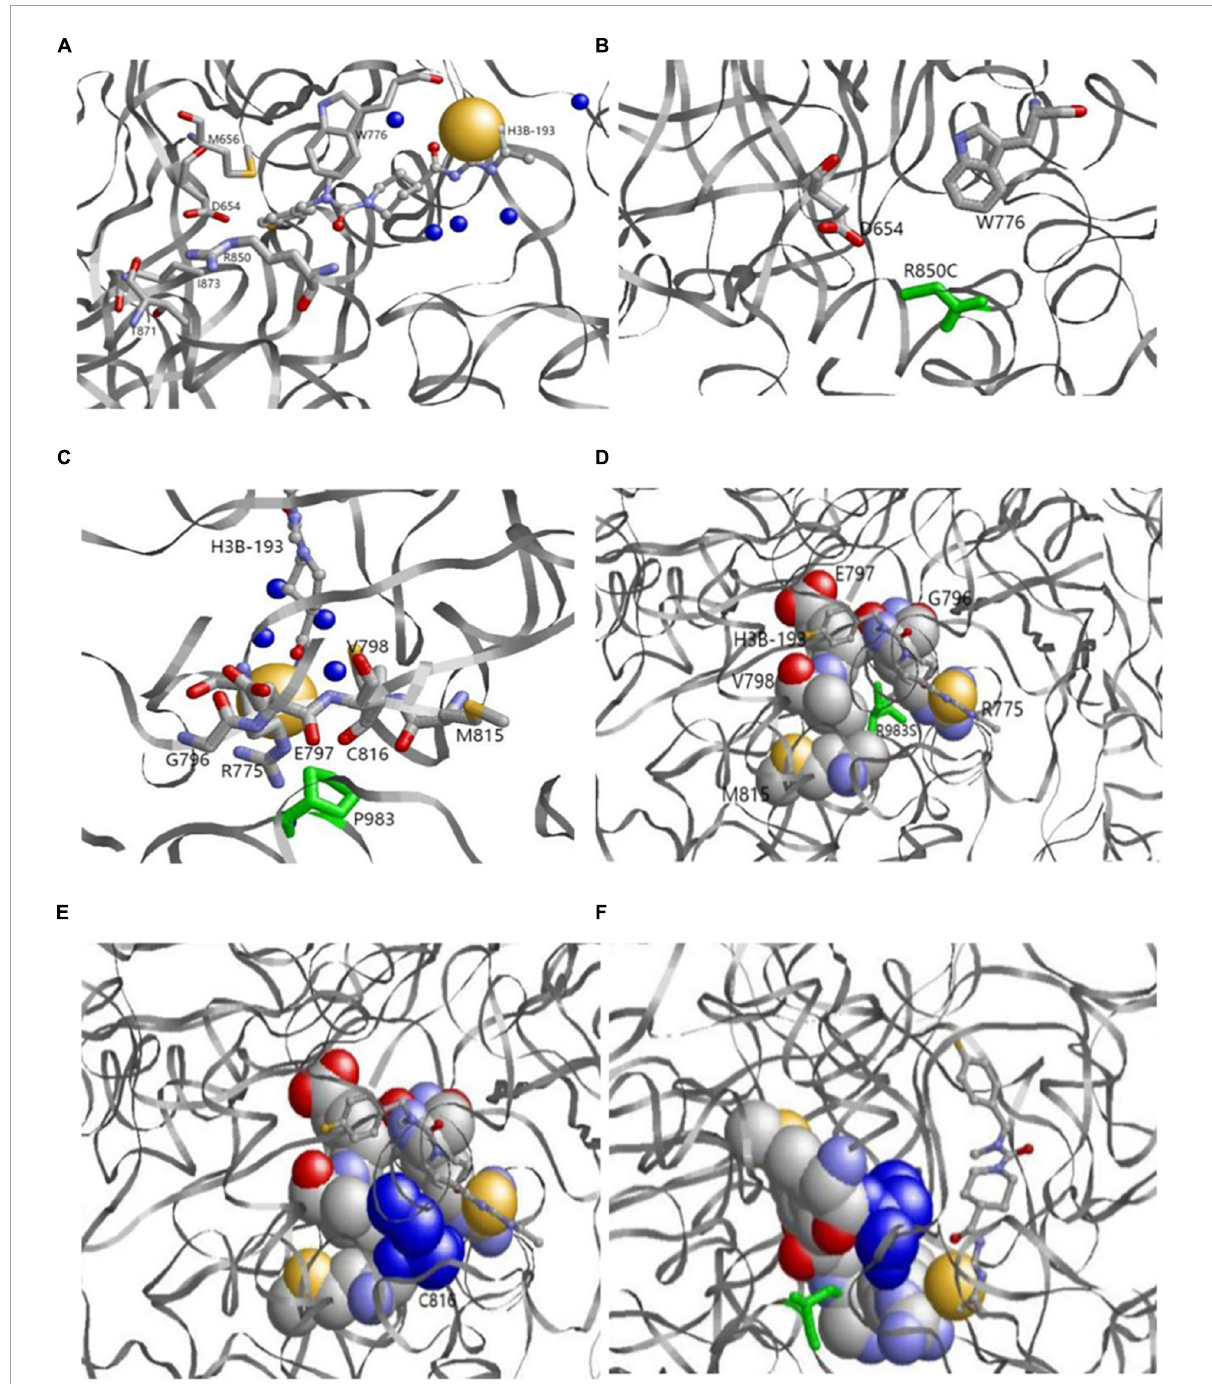
FIGURE5 (A,B) Original (a) and variant (b) models of p.R850. (A) Original p.R850 located near the binding pocket binds the ligand (allosteric inhibitor H3B-193) as well as P.D654, p.M656, p.W776, p.T871, and p.I873. (B) Variantp.R850C (green) reduces the binding partner in the pocket. p.R850C only binds to p.E654 and p.W776 . (C,D) Original p.P983model. p.P983 (green) is an important binding residue with part of the binding pocket containing residues p.R775, p.G796, p.E797, p.V798, p.M815, and p.C816. (E,F) Variantp.P983S model. Variantp.P983 (green) reduces the binding surface. p.C816 (blue) is a residue in the binding pocket and no longer binds with p.P983S. The left and right bottom images show the side views from the